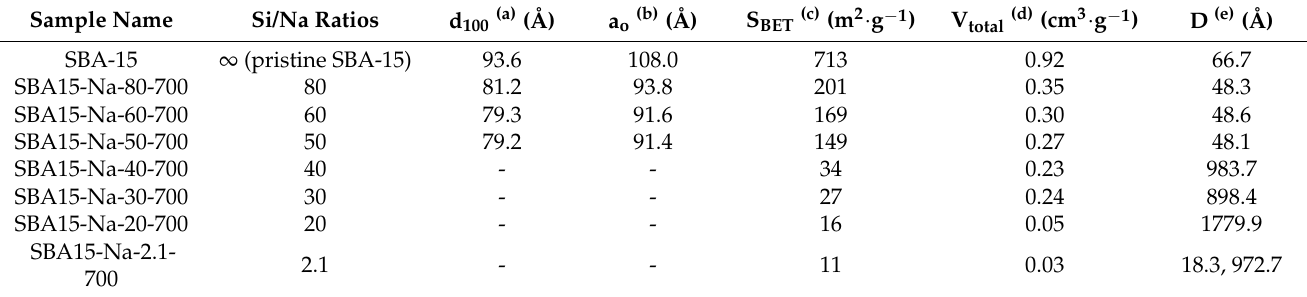
Figure 6. Nitrogen adsorption/desorption isotherm curves ( A ) and pore size distributions ( B ) of (a) SBA-15, (b) SBA15-Na-80-700, (c) SBA15-Na-60-700, (d) SBA15-Na-50-700, (e) SBA15-Na-40-700, (f) SBA15-Na-30-700, (g) SBA15-Na-20-700 and (h) SBA15-Na-2.1-700. Table 1. Physico-chemical properties of the samples synthesized at 700 °C with different ratios of Si/Na.